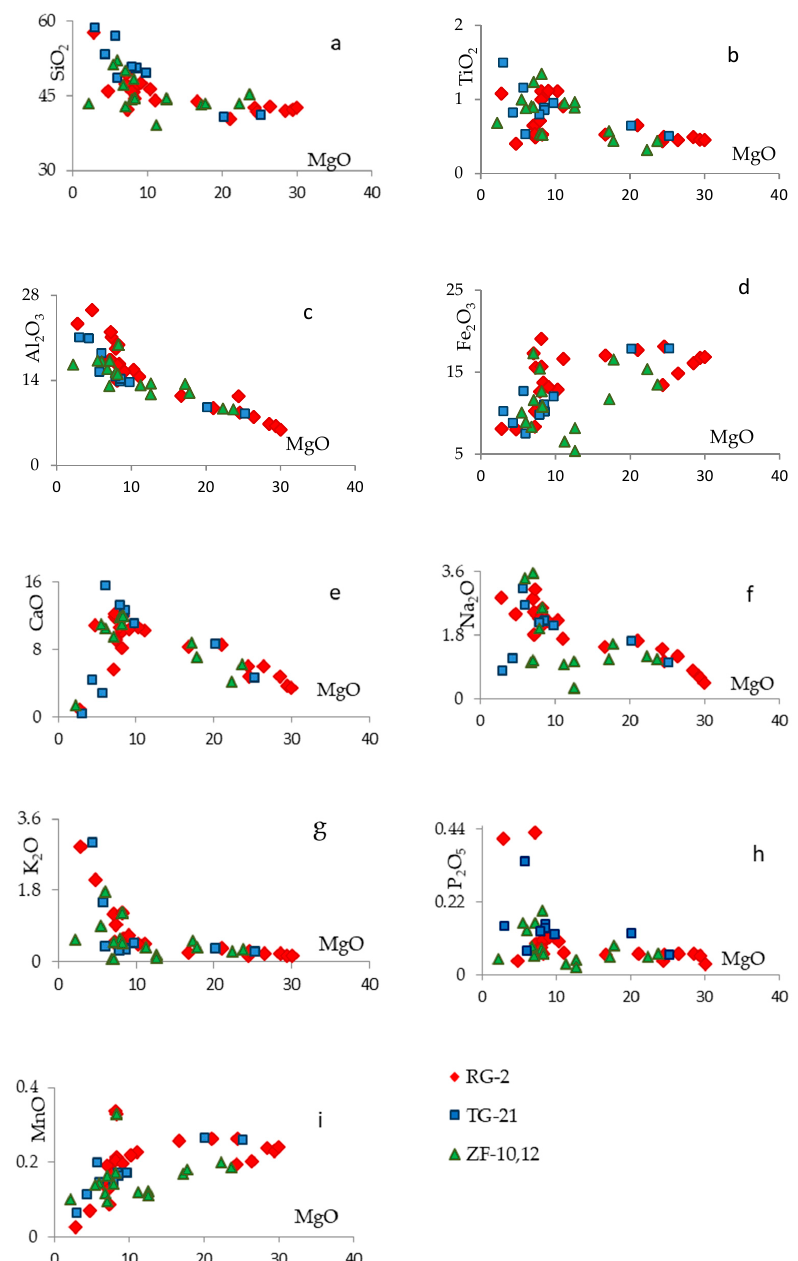
Figure 11. Diagrams MgO – SiO 2 ( a ), TiO 2 ( b ), Al 2 O 3 ( c ), FeO ( d ), CaO ( e ), Na 2 O ( f ), K 2 O ( g ), P 2 O 5 ( h ), MnO ( i ) (wt.%), for intrusive rocks of the Oktyabr’skoe deposit (boreholes RG-2, TG-21, ZF-10 + ZF-12).